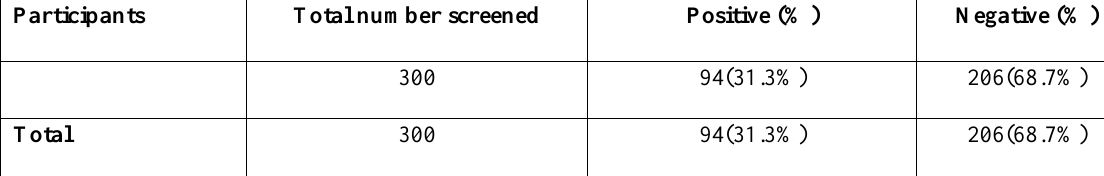
Table 2. Prevalence of astrovirus infection among study participants.